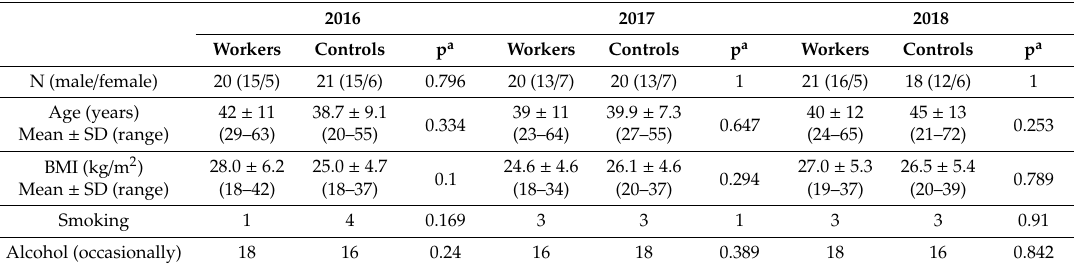
Table 1. General characteristics of the